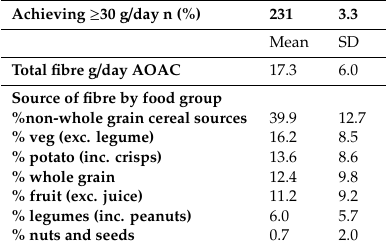
Table 2. Mean daily fibre intake and sources of intake from the Airwave Health Monitoring Study ( n =